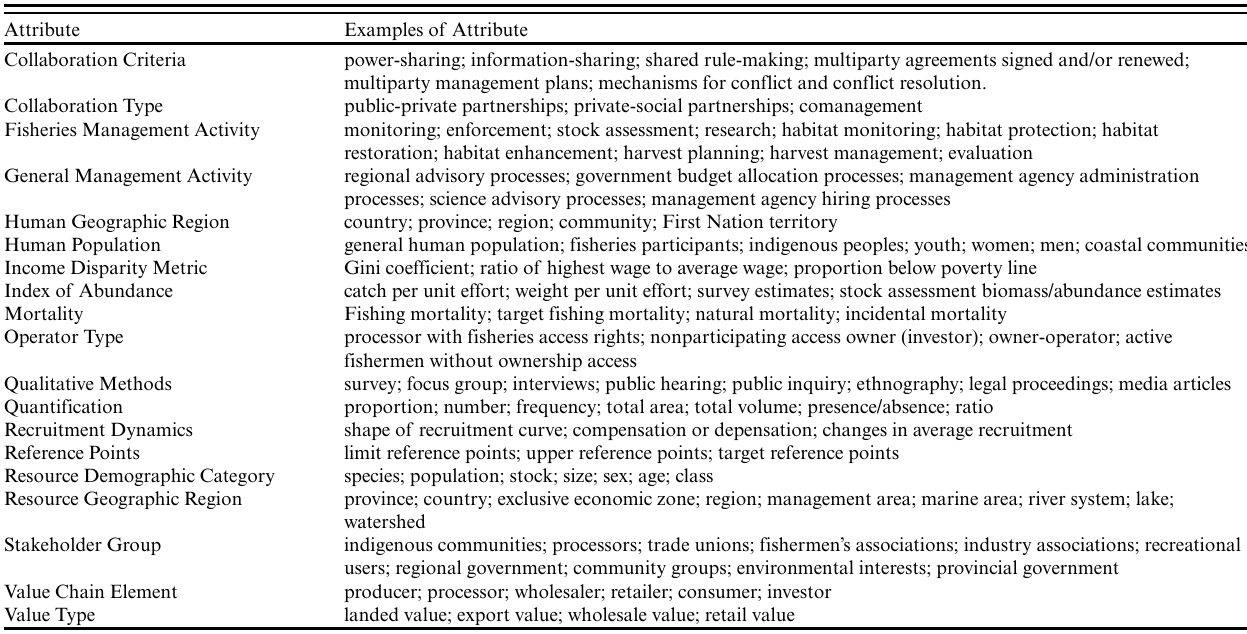
Table 5 . Example